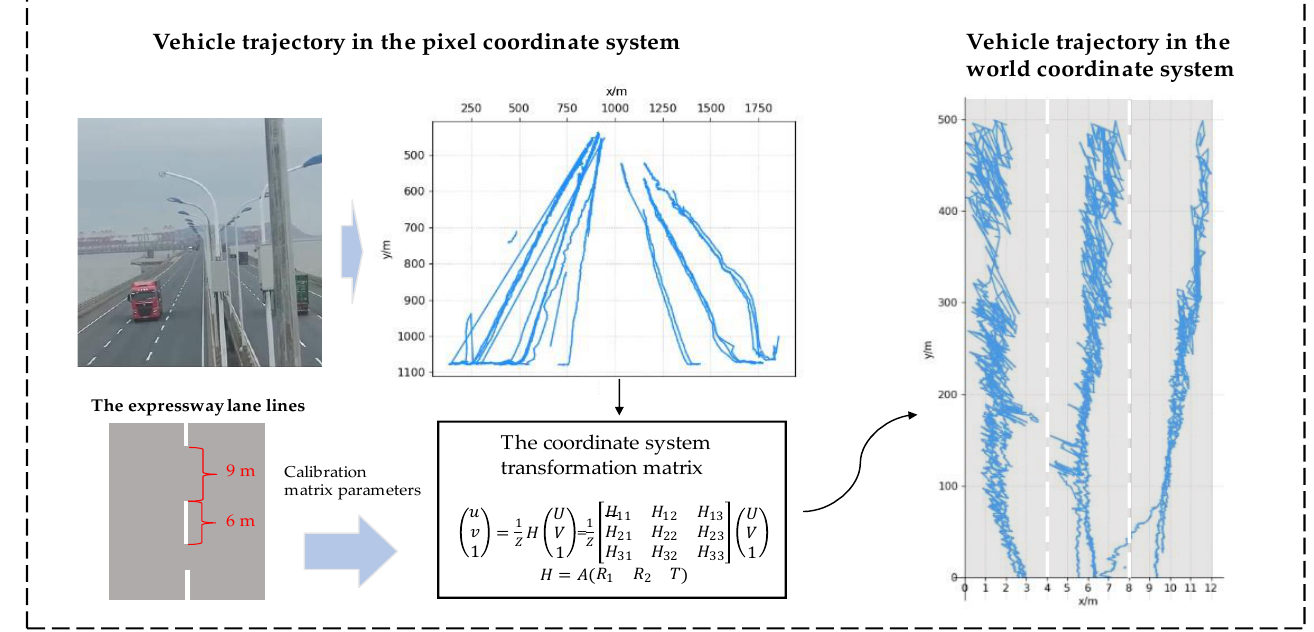
Figure 7. Single-region vehicle trajectory extraction in the world coordinate system.